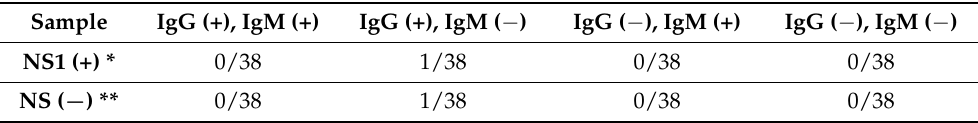
Table 2. The characteristics of healthy individuals (pre COVID-19 date) tested by dengue RDT ( n = 38) in Surabaya, Indonesia.